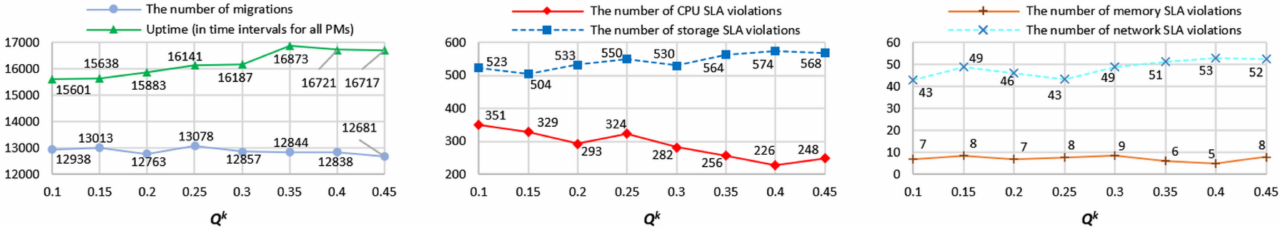
Figure 11. The effect of Q k on the quality metrics for SLA violation minimization. Thus, to achieve the minimum number of CPU SLA violations, it is necessary to set the model parameters as follows: L k = 0.1, T k = 0.15, D k = 0.95, and Q k = 0.4. The quality metrics of the SLA violation minimization are presented in Figure 12.